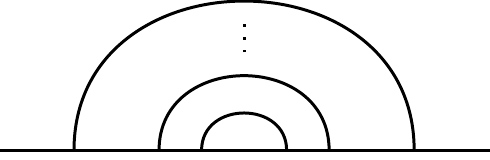
Figure 8 . Example of a class of R-Feynman diagrams contributing to the two-point functions (cor- recting ˆ G 1 in this case) at NNLO or higher orders in 1 /N , but at LO in √ λ at large distances in